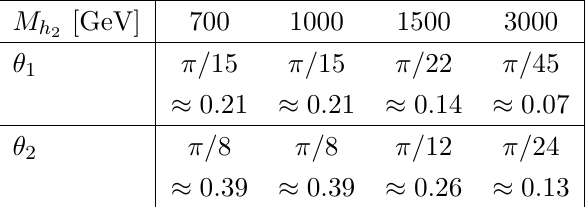
Table 1 . Mixing angles (cid:18) characterised by M h